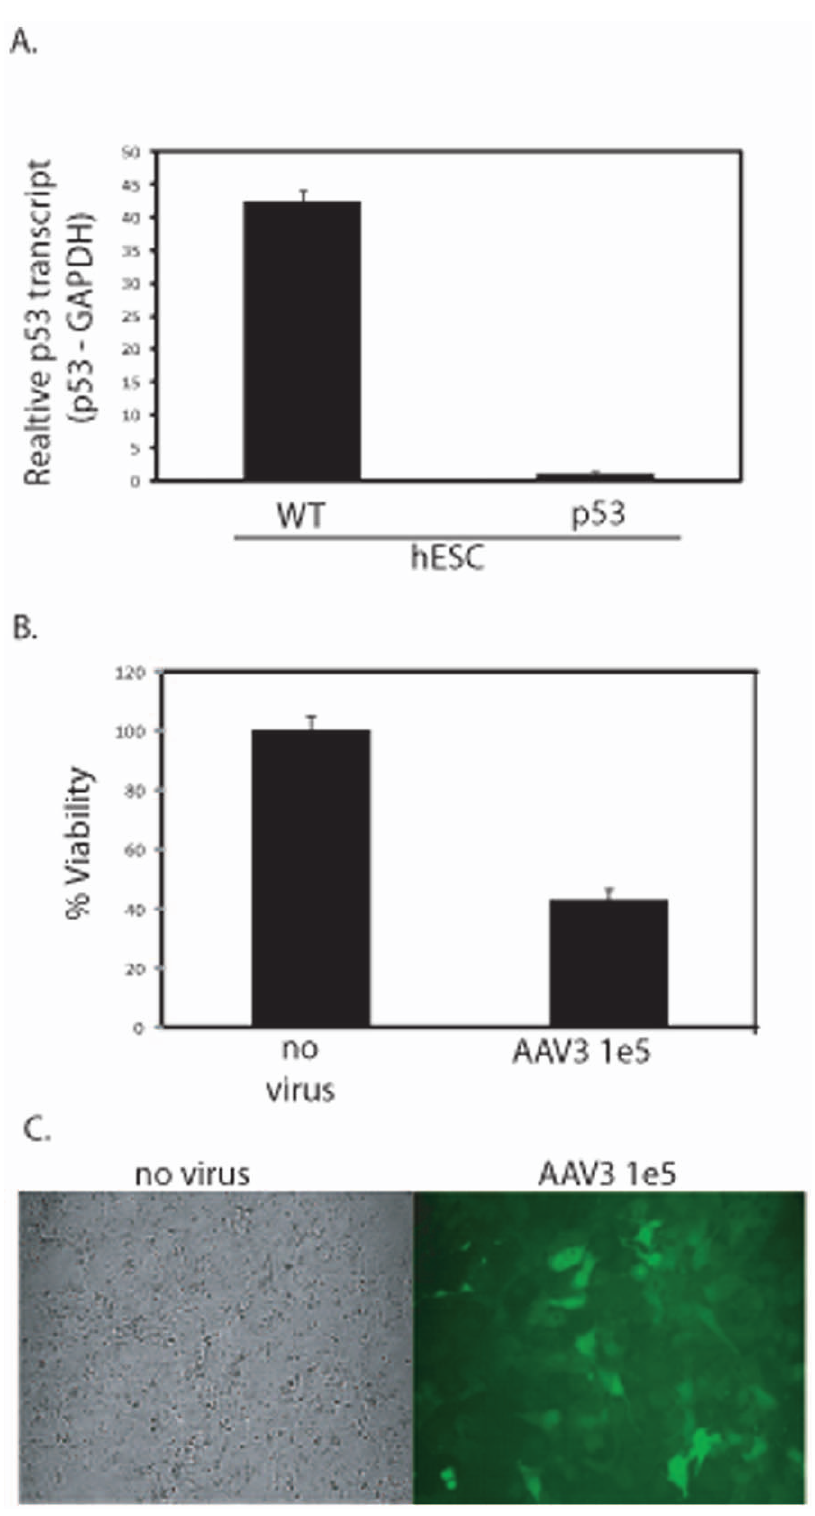
Figure 4. Recombinant AAV-Induced hESC Apoptosis is p53-Dependent. A polyclonal p53 deficient H9 hES cell line was constructed using lenti-viral transduction of a p53-specific shRNA cassette. After selection, total RNA was harvested, converted to cDNA and the relative abundance of p53 transcript, compared to the GAPDH housekeeping transcript, was determined by Q-PCR (A). The parental H9 hESCs were used as a wild type control (A). scAAV3B- egfp transduction of p53 deficient hESCs at a MOI of 100,000 was performed. 24 h post-infection viability was determined by dye exclusion (B) microscopy (C). The results in (A) and (B) are averaged from at least 6 replicates for each treatment group and the standard deviation is depicted. The differences noted in both (A) and (B) have p-values , 0.005).